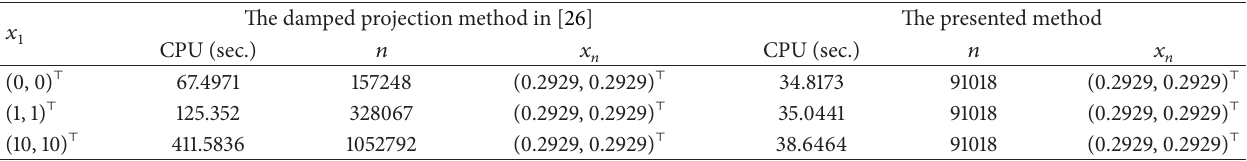
Table 1: Numerical results for Example 11.